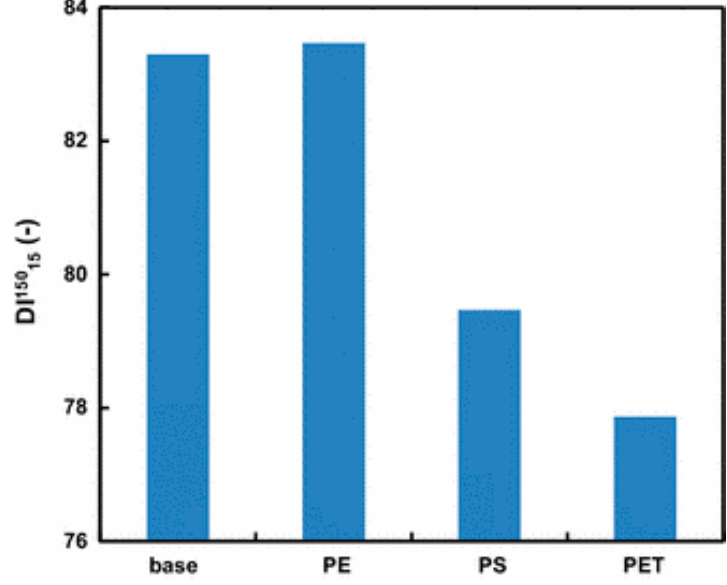
Figure 13. Effect of adding various plastics (2% mass) on coke strength DI 150 (Adapted from [50], with permission from © 2015 Springer Nature).